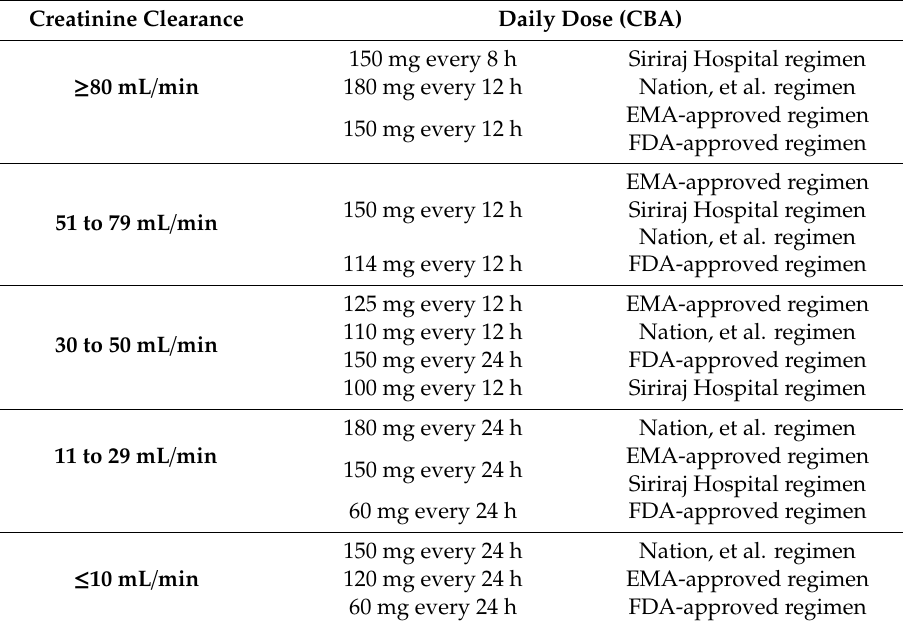
Table 2. Colistin dosage regimens for